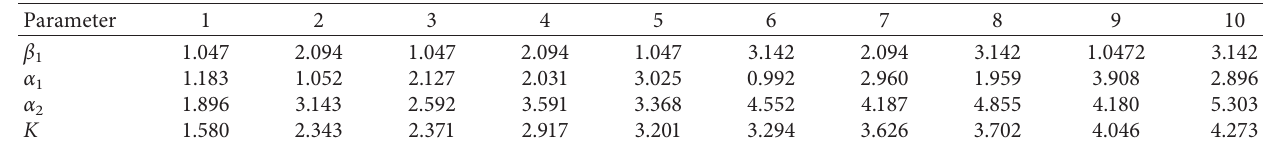
Table 6: The first 10 order vibration parameters of the thin plate rock mass under free vibration (S-C-S-C).